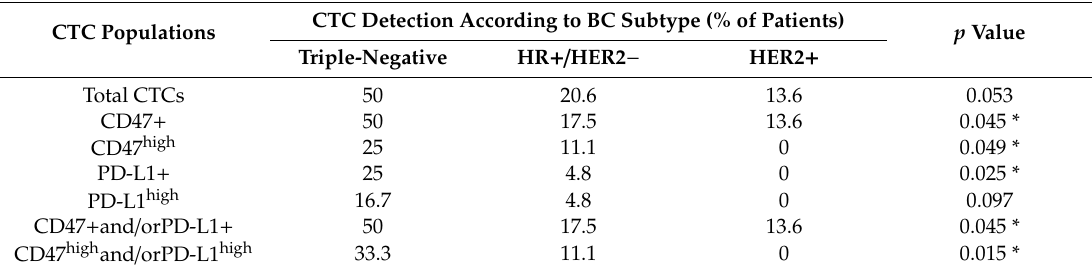
Table 2. Incidence of CD47 and PD-L1 expression on CTCs of patients with metastatic BC ( n = 97) according to the BC subtype.